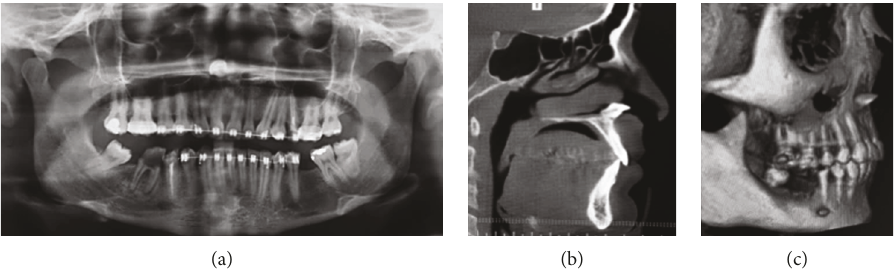
Figure 1: (a) Panoramic radiograph shows an ectopic tooth in the nasal cavity. (b) Sagittal cut of CT scan showing the horizontal orientation of the right superior incisor tooth inside the nasal nostril. (c) 3D reconstruction of CT scan showing the ectopic position of element 11.